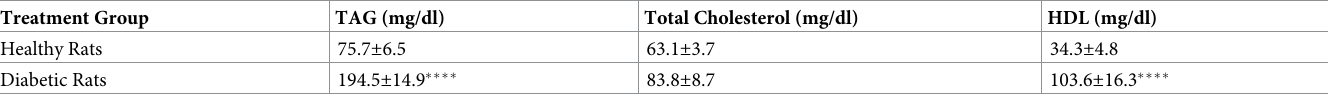
Colorimetric assays were performed to determine TAG, total cholesterol, and HDL in the plasma of the rats as stated in the Methods section.